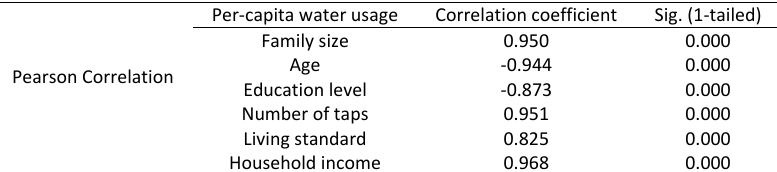
Table 2: Correlation between potential predictors – per-capita water usage